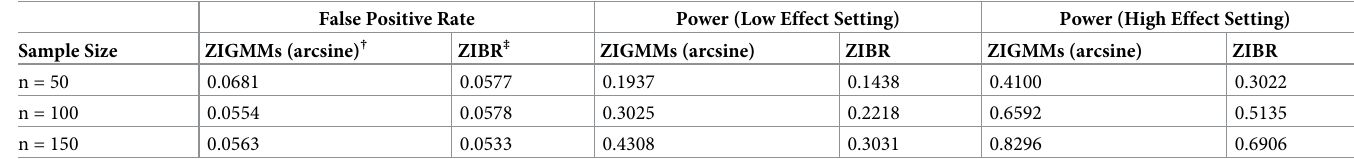
Table 1. False positive rate and power for testing H0: β 1 = 0 based on ZIGMMs and ZIBR for significance level at 0.05 for various sample sizes. False Positive Rate Power (Low Effect Setting) Power (High Effect Setting) Sample